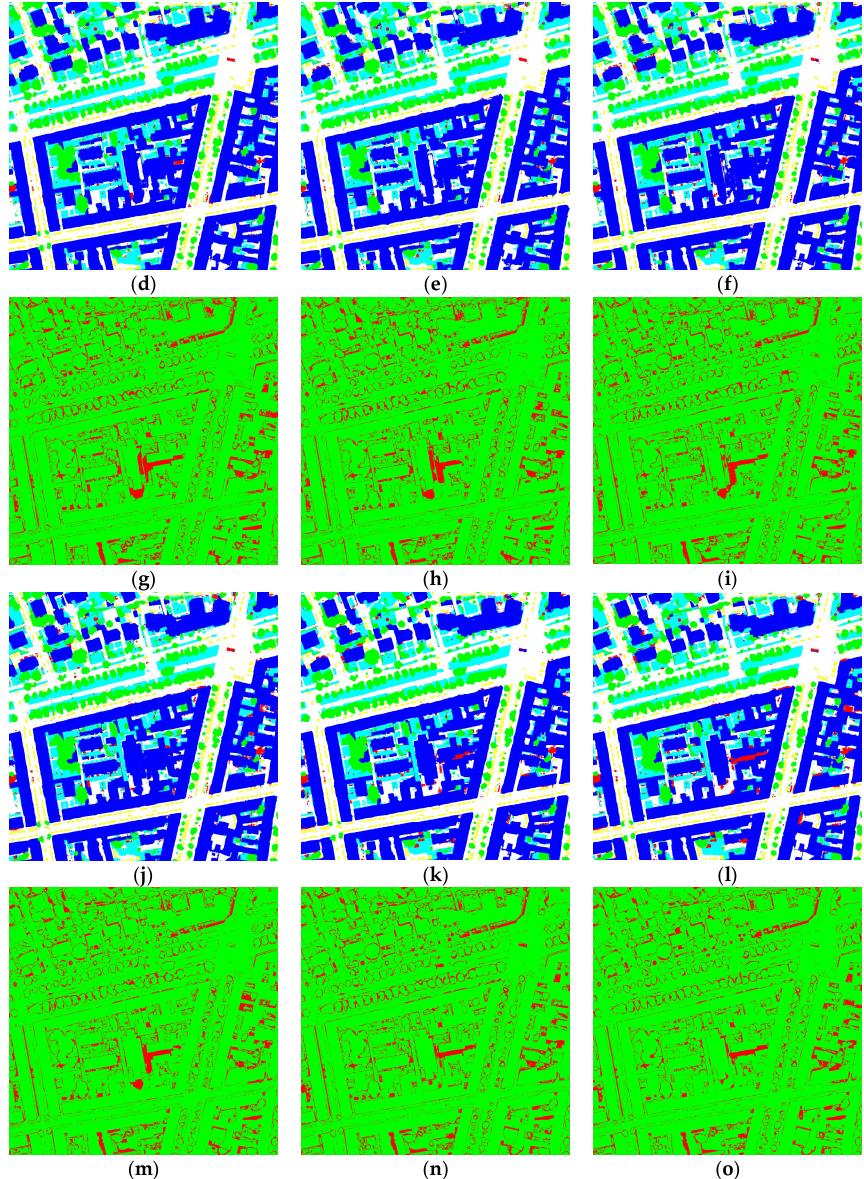
Figure A4. Full tile prediction for NO. 5_11 of Potsdam dataset. Classes: impervious surface (white); buildings (blue); low vegetation (cyan); tree (green); car (yellow); clutter (red). ( a ) TOP, true orthophoto; ( b ) nDSM, normalized DSM; ( c ) GT, ground truth; ( d – f ) inference result of FCN-8s, SegNet, and FSN-noL, respectively; ( g – i ) Red/Green Images of FCN-8s, SegNet, and FSN-noL, respectively; ( j – l ) inference result of HSN, FSN and FSN + CRFs respectively; and ( m – o ) Red/Green Images of HSN, FSN and FSN + CRFs, respectively.